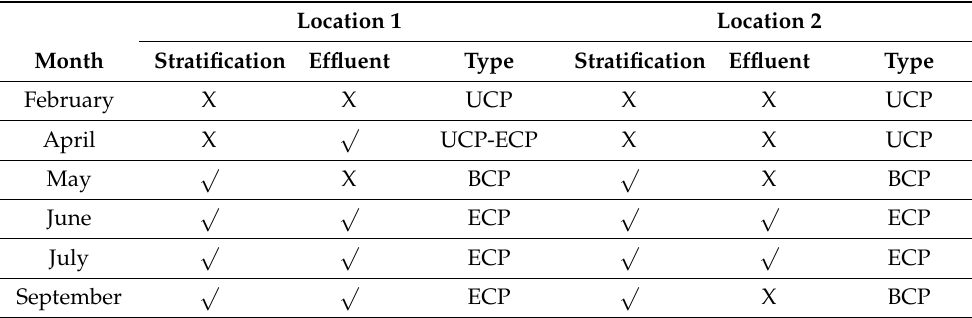
Table 2. Vertical profile classification